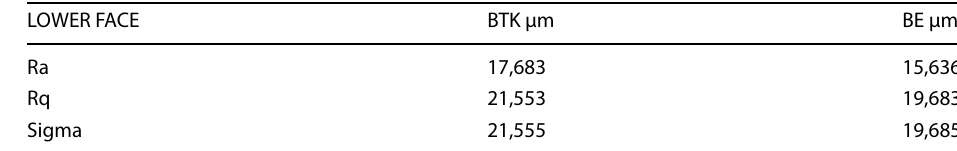
Table 1 Roughness parameters on lower faces of